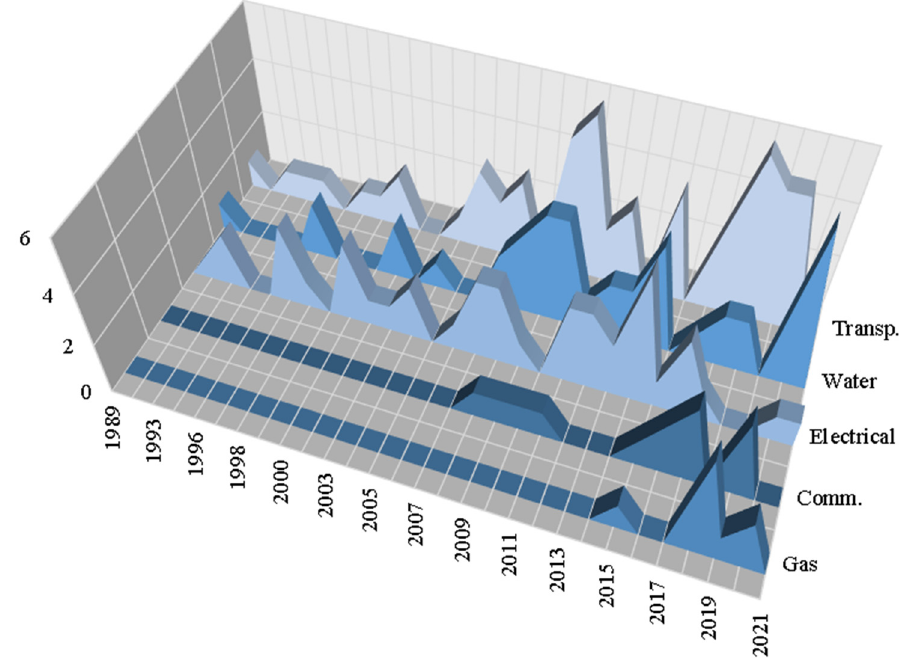
Figure 16. Publishing rate of infrastructure research for each considered subject.